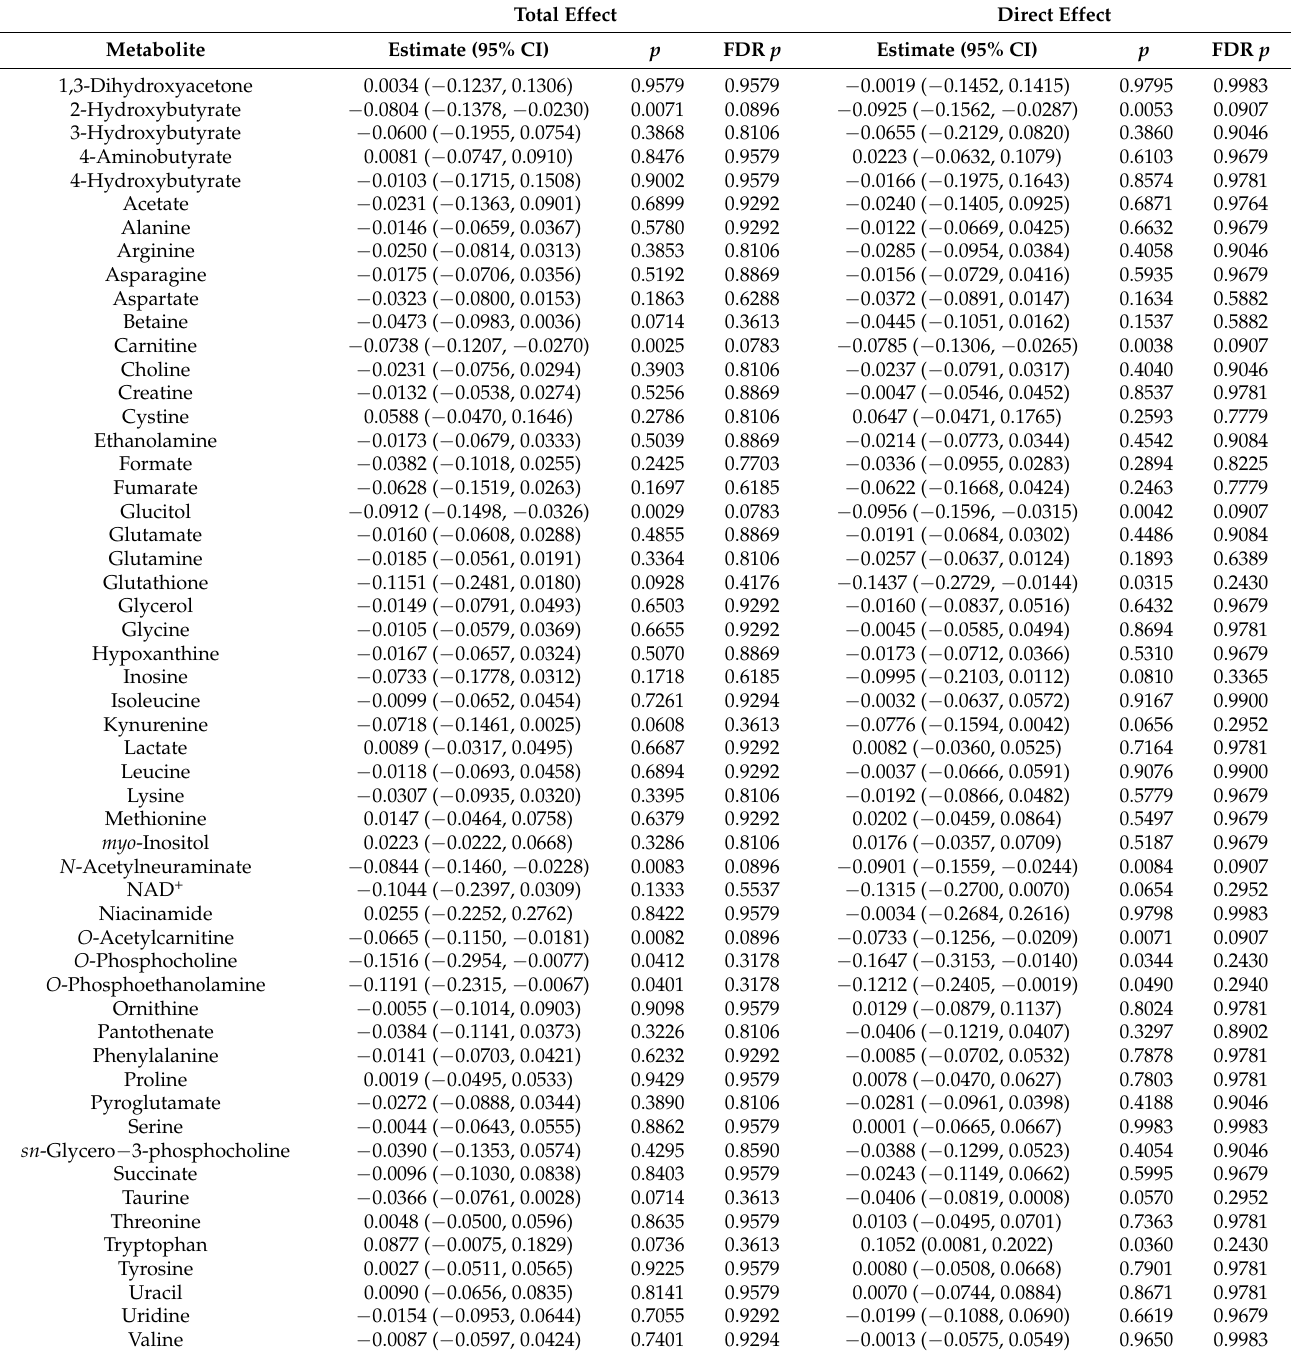
Table 2. Estimates of the total and direct effects of a 1 quartile increase of each phthalate metabolite in the mixture of each placental metabolite. The estimate and 95% confidence interval (CI) for each placental metabolite were bootstrapped independently using quantile g-computation models. The total effect was adjusted for birth year, homeownership, maternal education, and maternal race/ethnicity. The direct effect models were adjusted for birth year, delivery mode, gestational age at birth, homeownership, maternal education, maternal metabolic condition, and maternal race/ethnicity. All p -values were adjusted for false discovery rate (FDR) and both the original and FDR p -values are